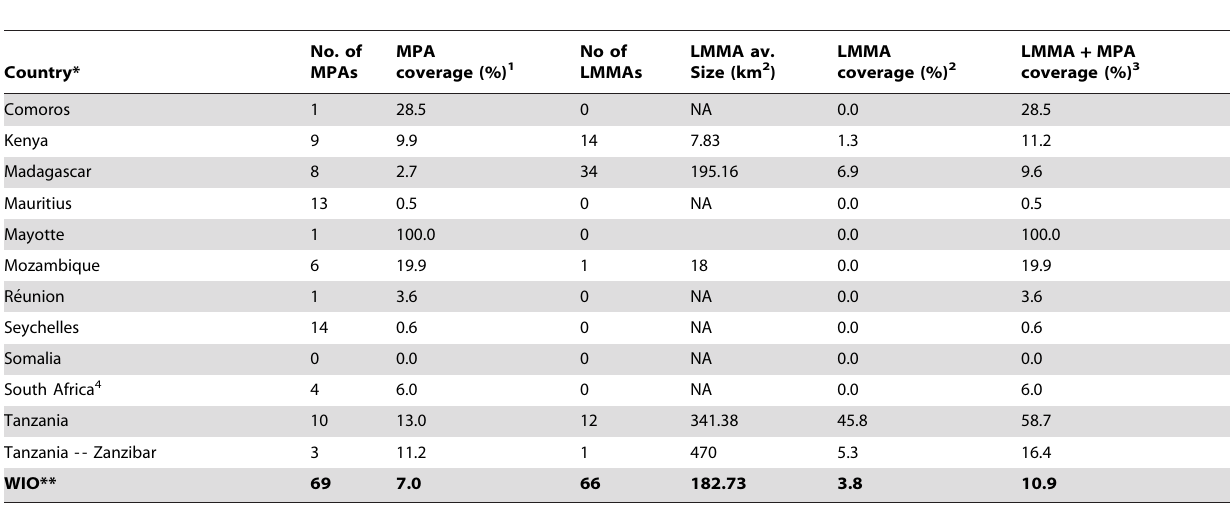
Table 4. Extent of MPA (level 1 and 2) and LMMA (level 3 and 4) coverage and current progress towards achieving international biodiversity conservation